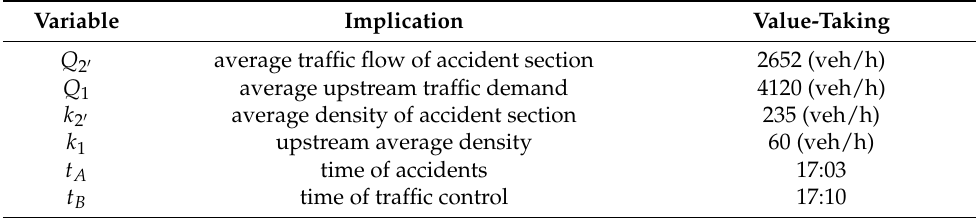
Table 2. Parameter information for maximum queue length